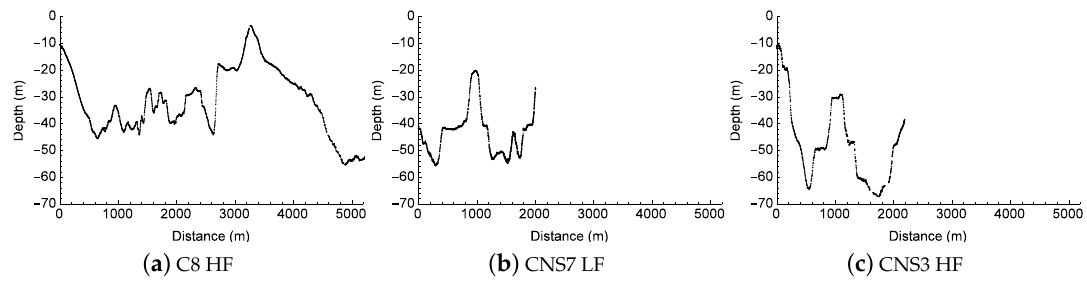
Figure 3. Lateral profiles of flow